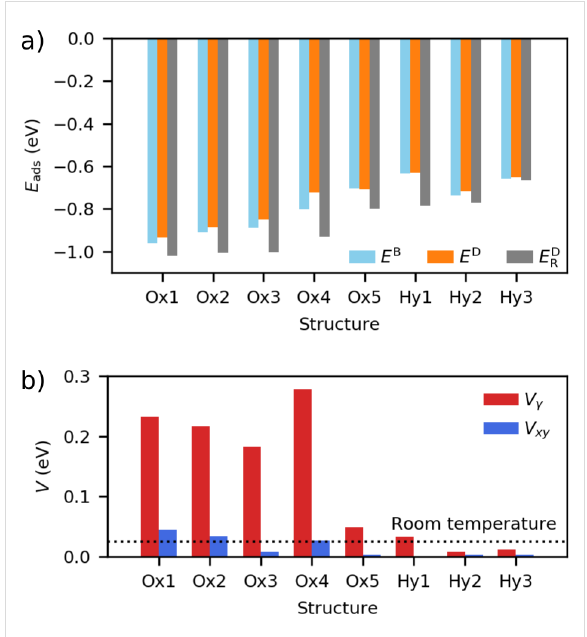
Figure 5: Energetics of adsorption and mobility for surface adsorbates. (a) Adsorption energies ( E ads ) of the stable adsorbates predicted by BOSS ( E B ), their true values calculated with DFT ( E D ) and the adsorp- tion energies of the relaxed structures ( ). (b) Energy barriers ( V ) for γ rotation ( V γ ) and x – y translation ( V xy ), in comparison with thermal energy at room